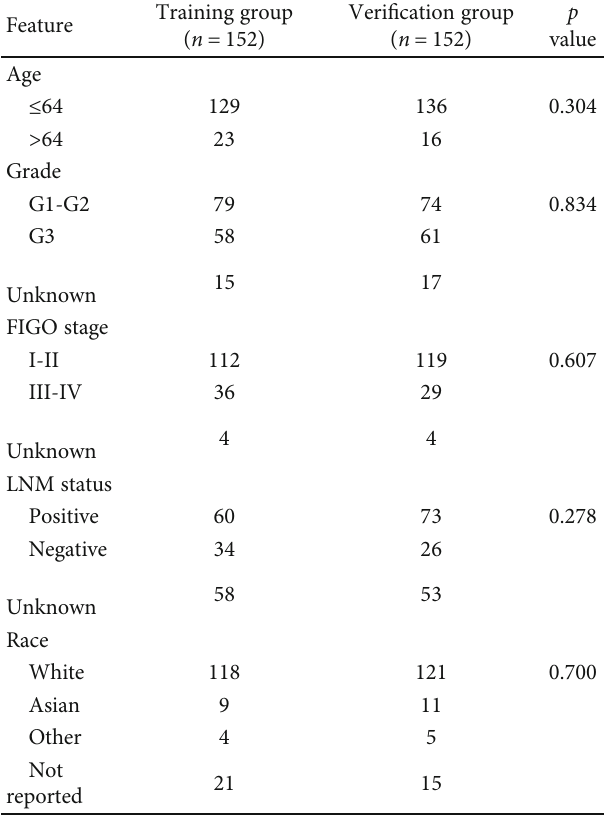
CC: cervical cancer; FIGO: Fédération Internationale de Gynécologie et d ’ Obstétrique; LNM: lymph node